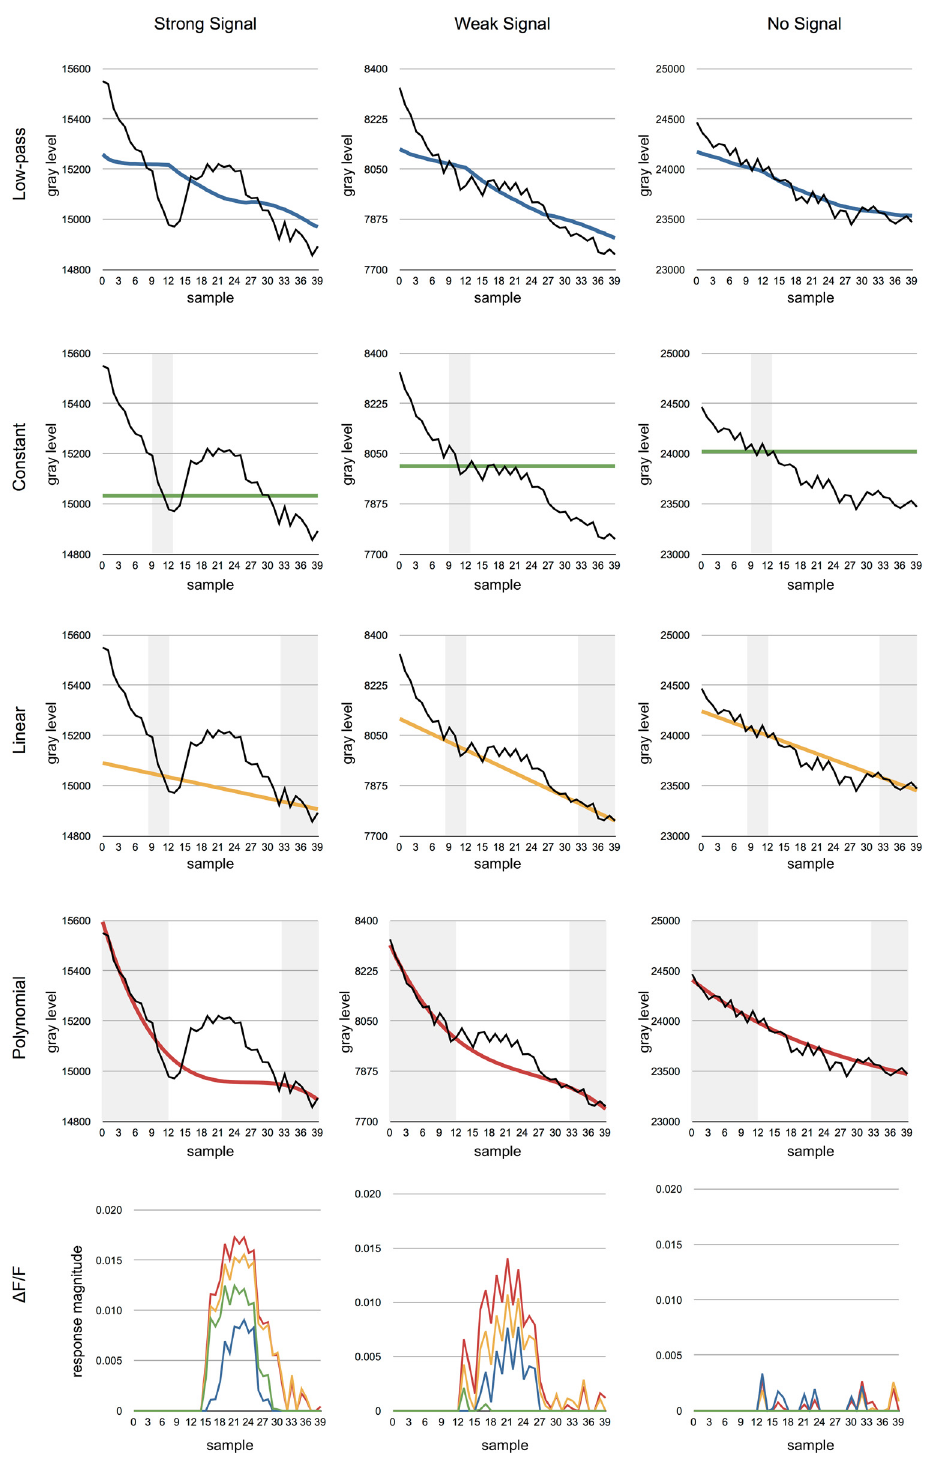
Fig 3. The results of applying the different methods to the example data from Fig 1. The grey regions indicate data used for the approximation of the background function F which is shown in different colours. The black line shows the raw signal. Left column. All of the methods are able to recover the signal when it